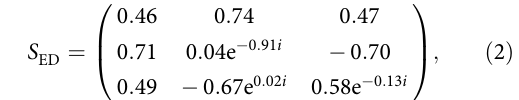
Fig. 1. The entries S ab encode the braiding properties of quasiparticles a and b in the underlying TQFT ( fi xing the entries to certain universal values) and thereby allow for its unambiguous identi fi cation. Numerically, we fi nd, e.g., the following S -matrix